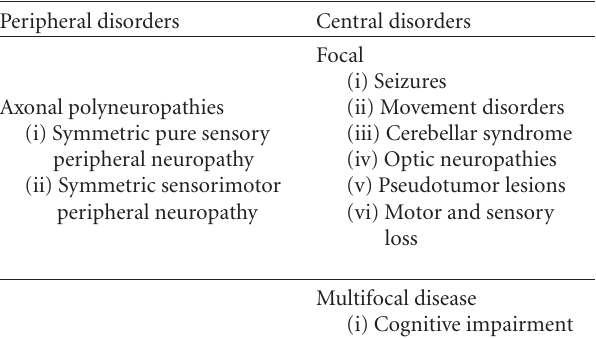
Table 1: Neurological manifestations in primary Sj¨ogren’s syn-